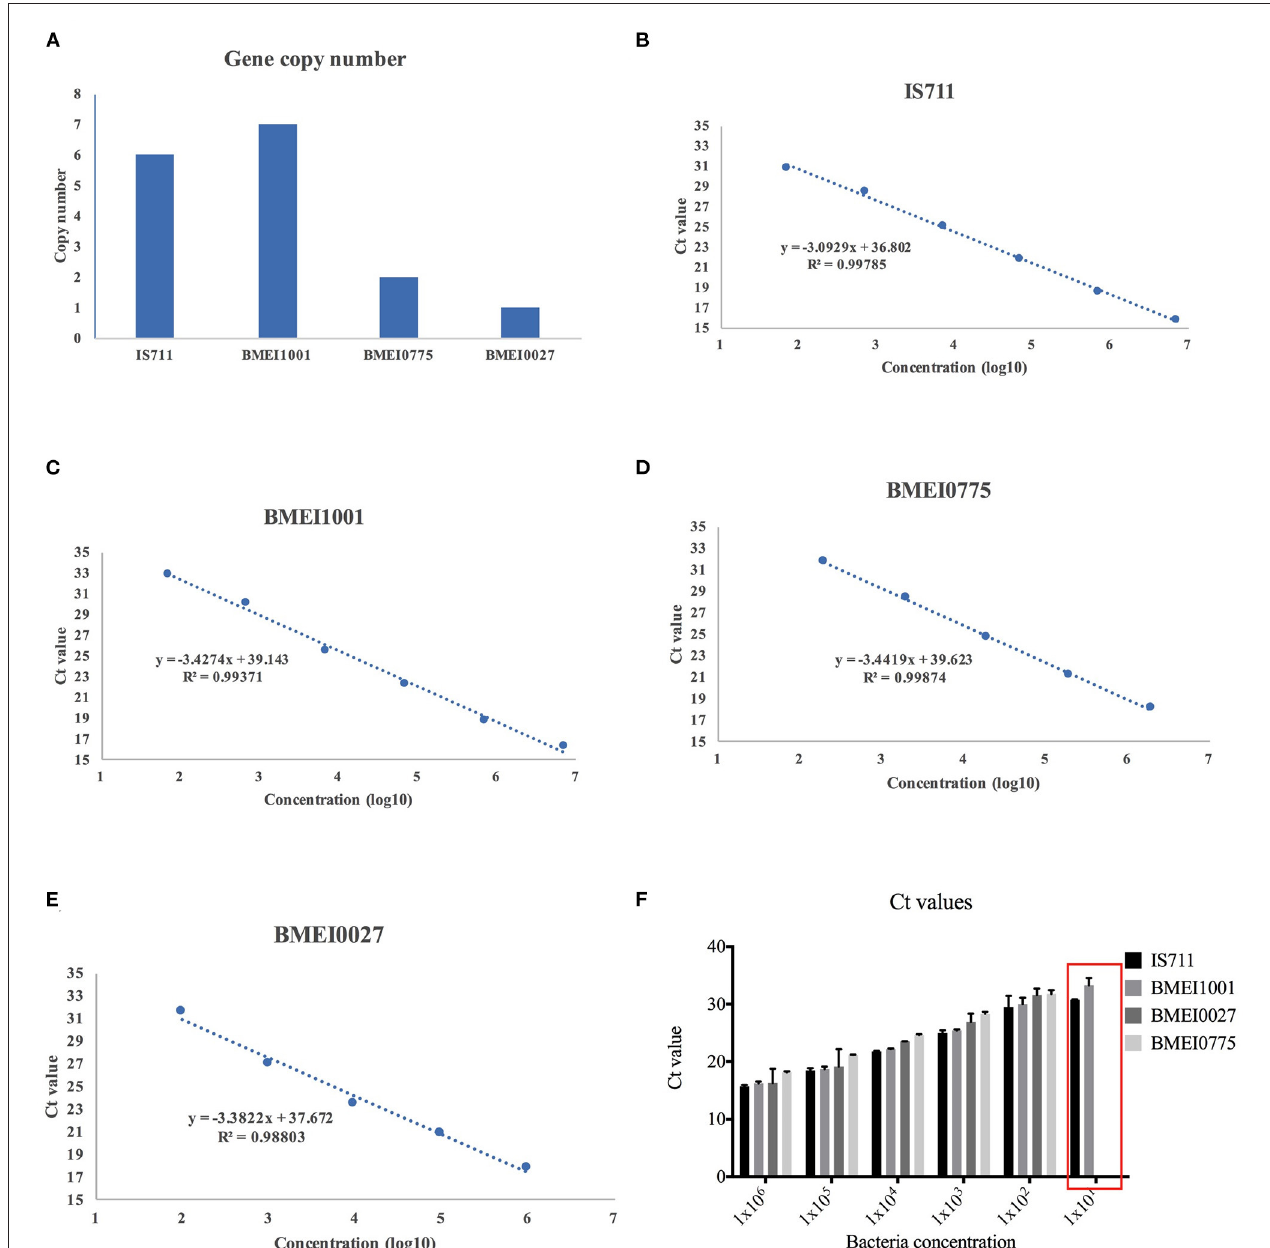
FIGURE 2 | Detection efficiency of signature genes with varying copy number. Four candidate signature genes, IS711, BMEI1001, BMEI0775, and BMEI0027, with varying copy numbers were selected (A) and serial dilutions of bacteria culture were assayed with primers for the four genes. Quantification curves of IS711 (B) , BMEI1001 (C) , BMEI0775 (D) , and BMEI0027 (E) were generated. High copy genes IS711 and BMEI1001 showed higher sensitivity than low copy genes BMEI0775 and BMEI0027 (F)